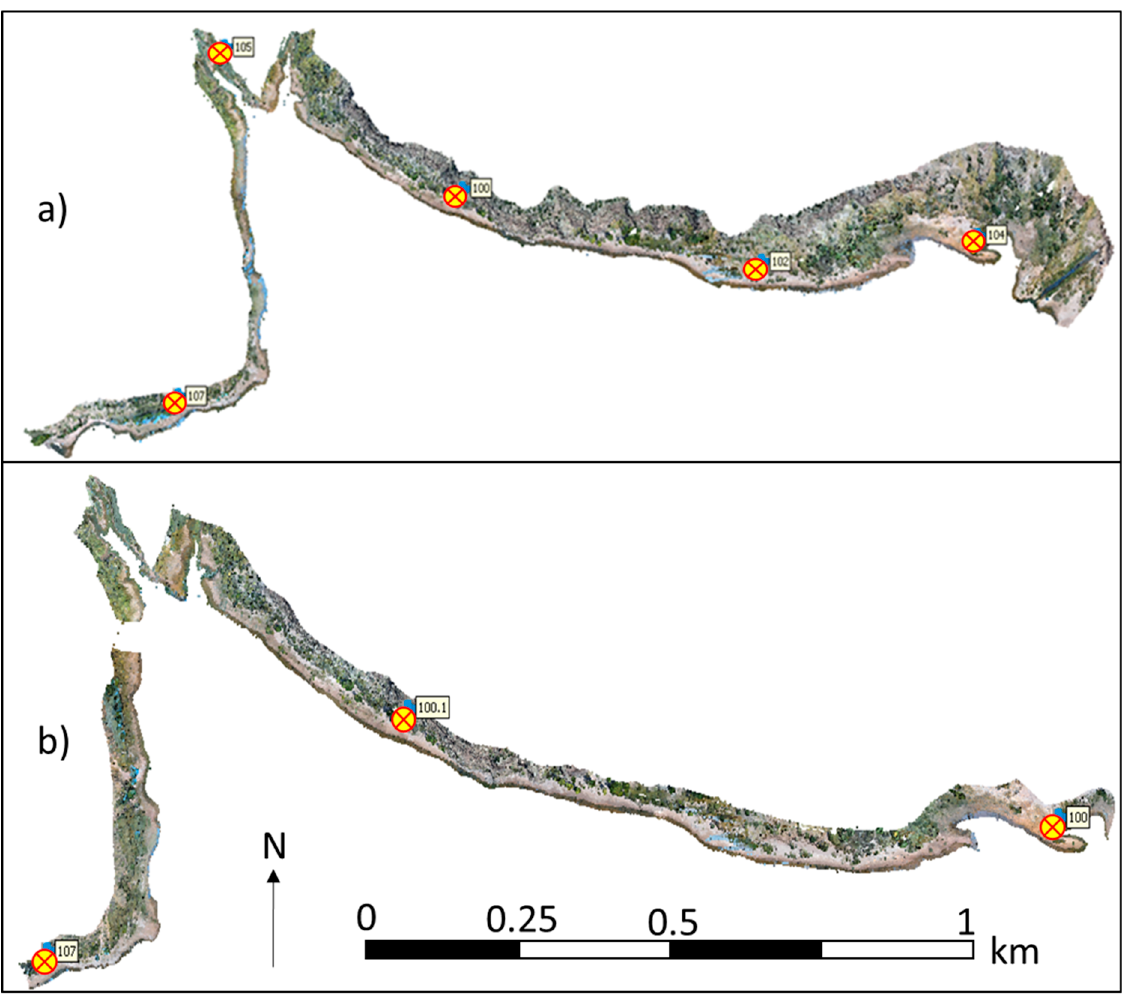
Figure 6. Starvation GCP spacing with ( a ) 0.8-km (0.5-mile) spacing shown and ( b ) 1.6-km (1-mile) spacing shown.